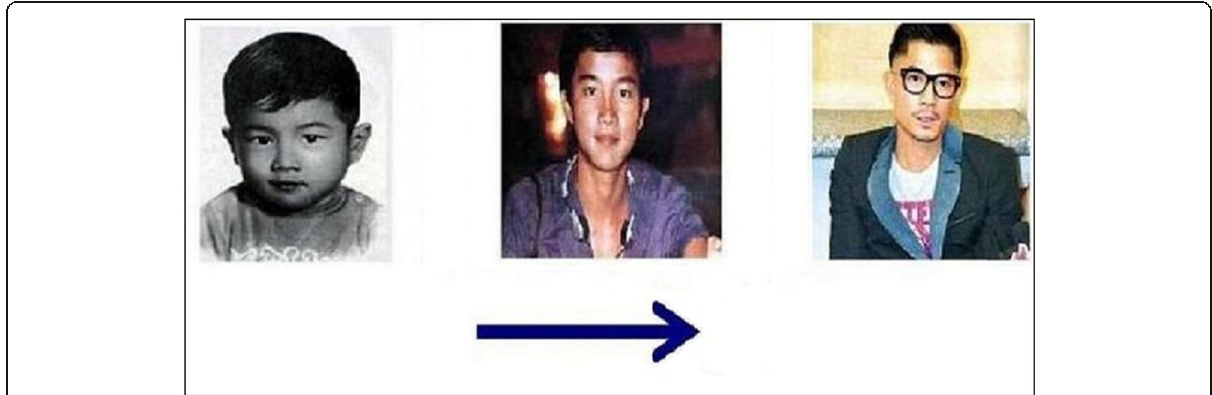
Fig. 3 An example of a horizontal space-time compatible target. This is an instance of a true condition